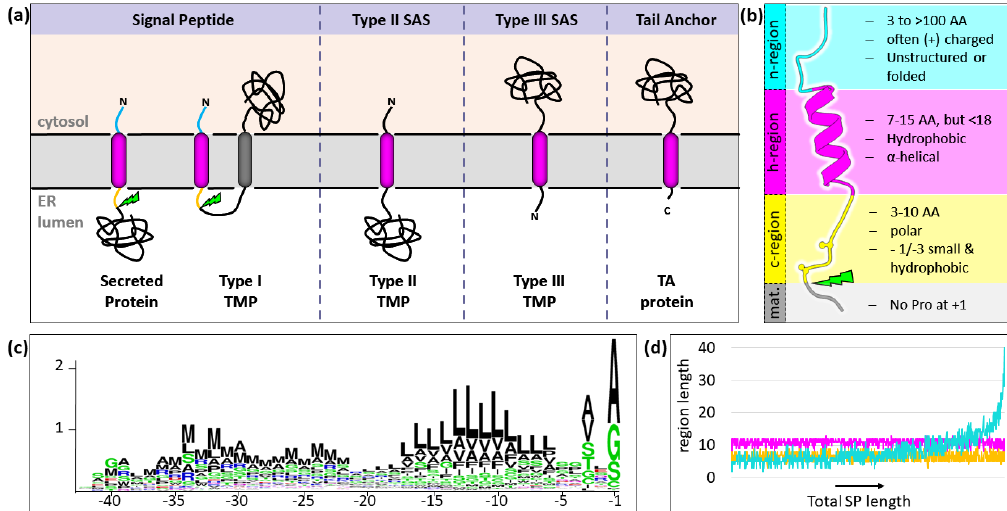
Figure 1. Types of signal sequences. ( a ) Depiction of the four types of SSs with their membrane topology indicated. Hydrophobic segments are depicted in magenta. ( b ) Signal peptides have a tripartite structure, consisting of an n- (cyan), h- (magenta), and c-region (yellow) and are cleaved in the ER lumen by the SPC (green flash). ( c ) Frequency of residue types relative to the cleavage site [5]. ( d ) Relative length of the respective regions (colored as in ( b )) as a function of total SP length. The bulk of the length variation stems from the n-region. Panels c–d were adapted from [5].